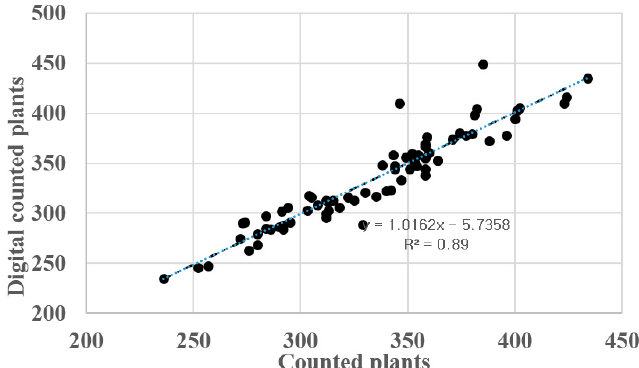
Figure 8. Correlation of visually counted plants serving as reference and the digitally recorded plant number. The ground cover indicated by the green pixel percentage ranged for all cultivars between 76% and 87%. Significant differences in the nitrogen levels were not observed at the investigated growth stages.